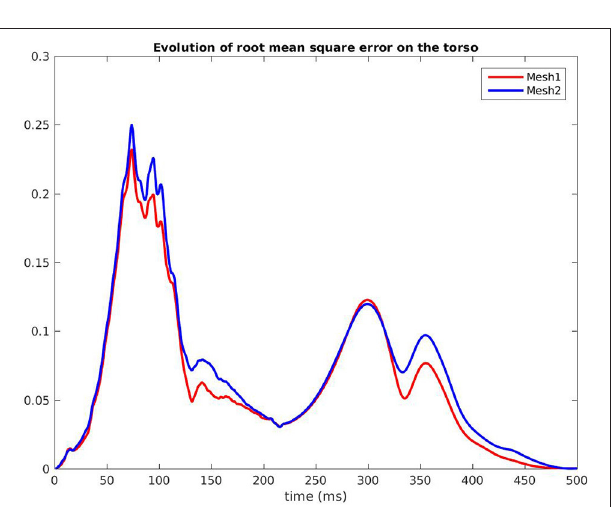
FIGURE 9 | Root mean square error of the BSPM, RV pacing